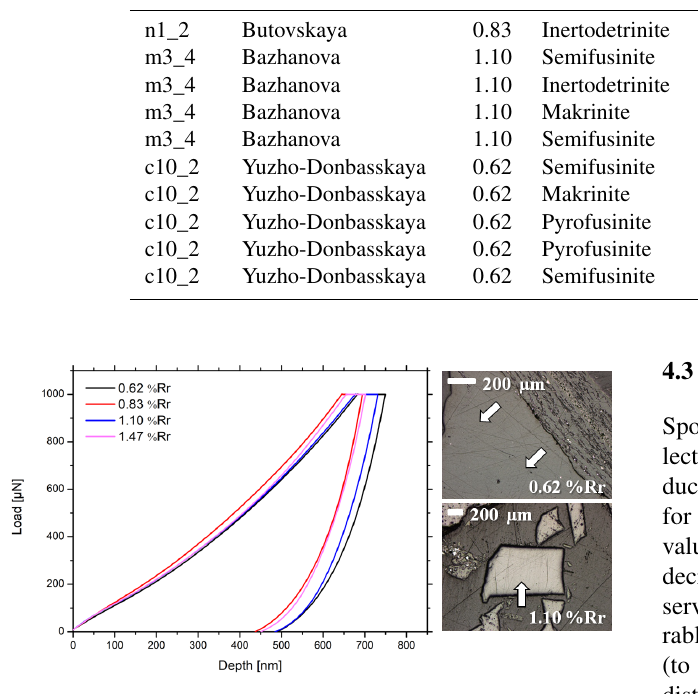
Figure 5. Averaged load-displacement curves for vitrinites at differ- ent coal rank. Slightly differing deformation behaviour is indicated by the individual curve shapes. However, a general elasto-plastic behaviour dominates at all maturity ranges. The insets show micro- graphs of typical indentation